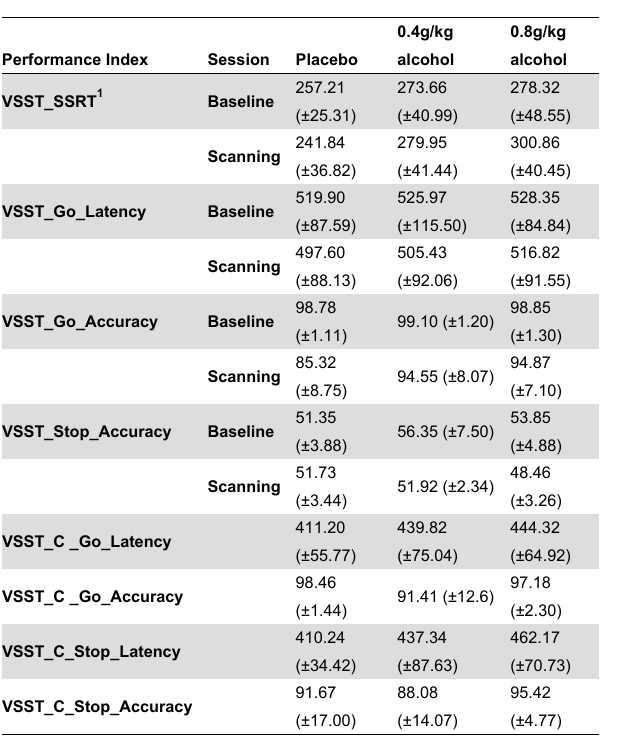
Table 5. Activations resulting from conjunction analysis of Sstop>Go and Stop_VSST_C>Go_VSST_C contrasts in the placebo group (p <.005, unc. k ≥ 13 voxels).